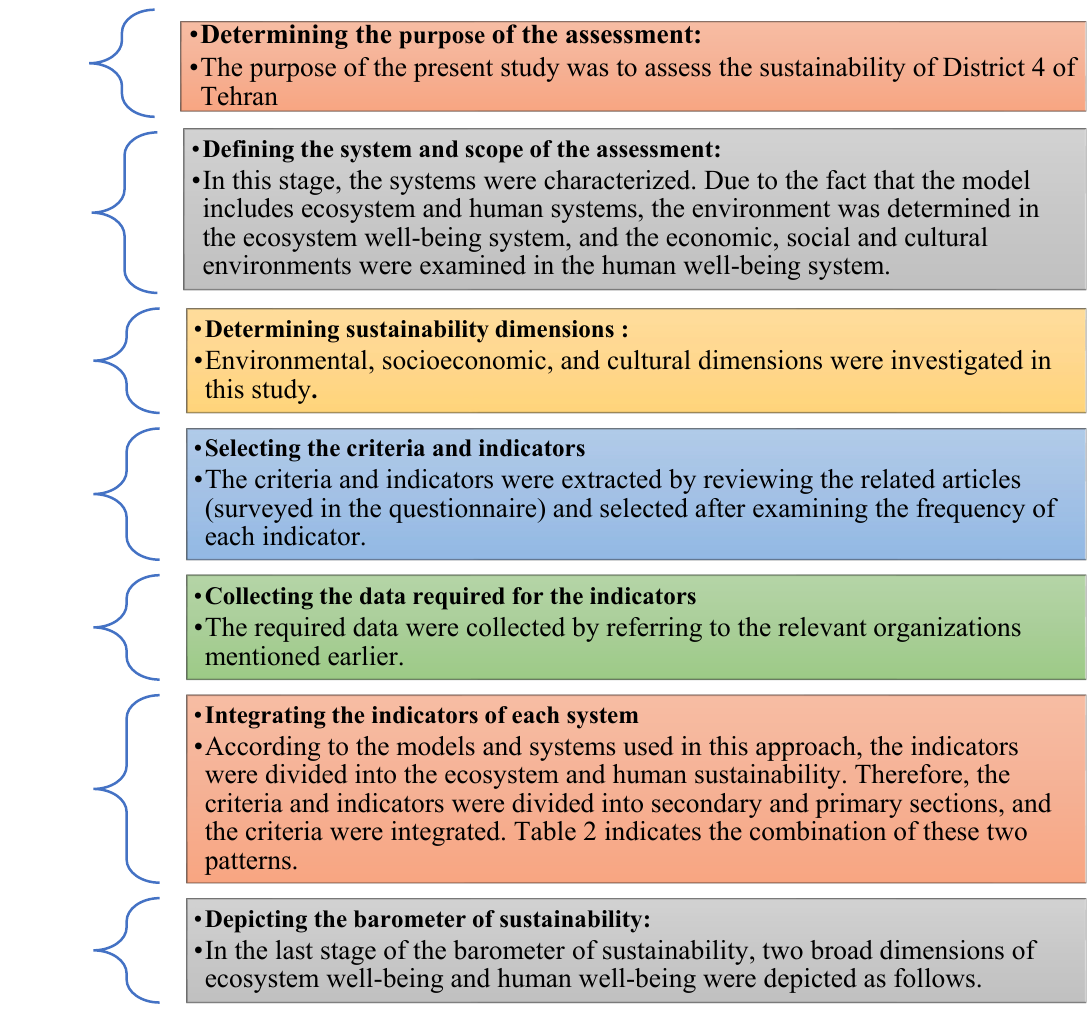
Figure 5. Description of IUCN method steps.